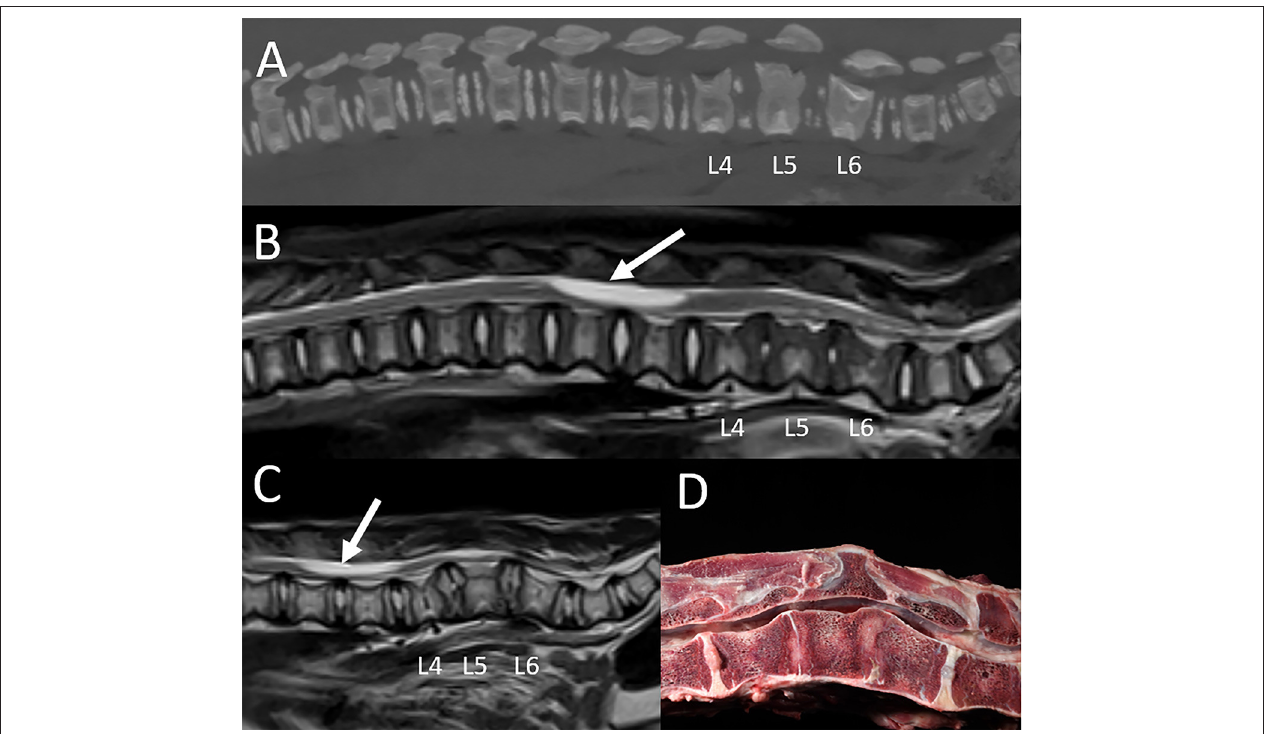
FIGURE 9 | Vertebral dysplasia in a liger. MRI and CT were performed at 0.75 years of age, and the MRI examination was repeated at 1.25 years of age. (A) Sagittal reconstruction of the CT images, (B) sagittal T2-W image obtained at the first MRI examination, (C) sagittal T2-W image obtained at the repeat MRI examination, and (D) corresponding gross pathology image. Imaging findings include foreshortening and abnormal shape of the L4 through L6 lumbar vertebrae, with decrease in intervertebral disc space width, decrease in size and normal T2 hyperintense signal of the intervertebral discs, dorsal protrusion of the intervertebral discs, lumbar kyphosis, and spinal cord compression. A large cyst-like intramedullary lesion was identified, most consistent with a syrinx with other cystic conditions not excluded (arrow). Autopsy (D) confirmed vertebral dysplasia with severe syringohydromyelia.